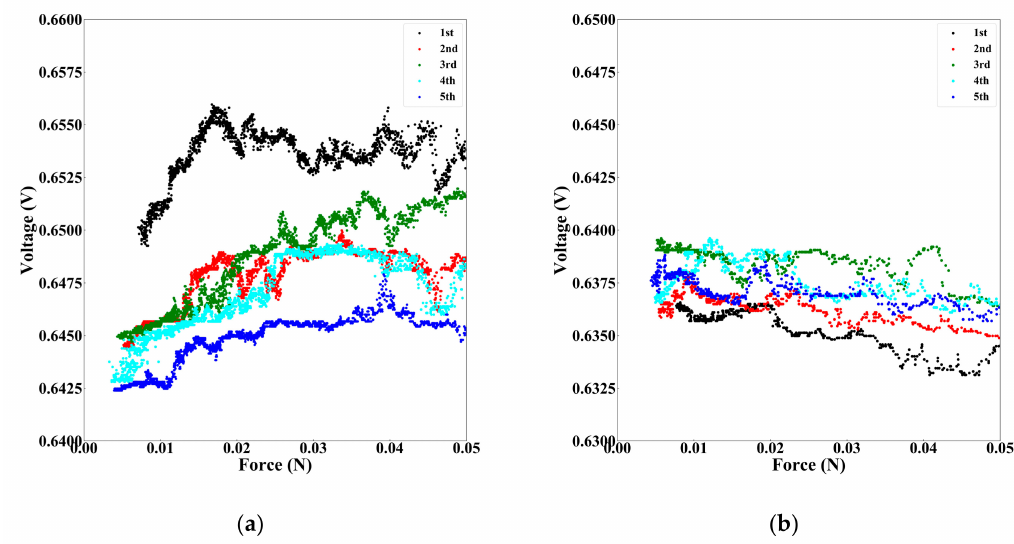
Figure 8. The response of soft-MPS in low load area. ( a ) Changes of voltage on soft-MPS (soft) vs. force. ( b ) Change of voltage on soft-MPS (hard) vs.